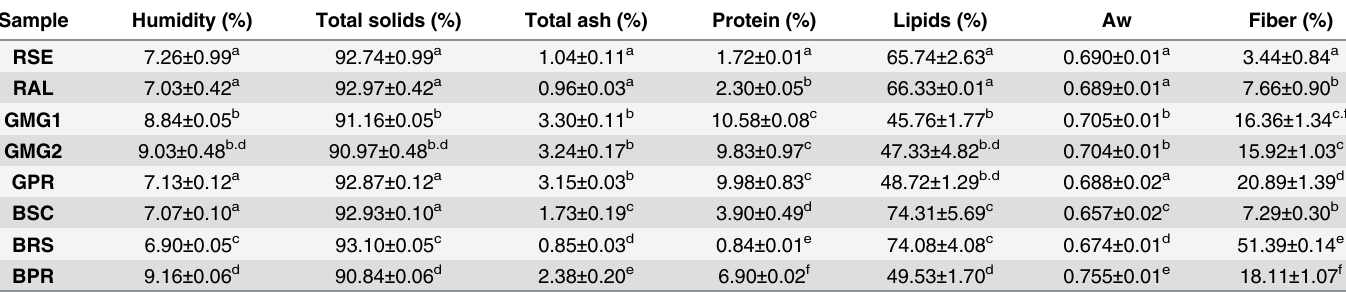
Values showing the same letter on the same column do not show signi fi cant difference (p > 0.05) through the Tukey test at 95% con fi dence